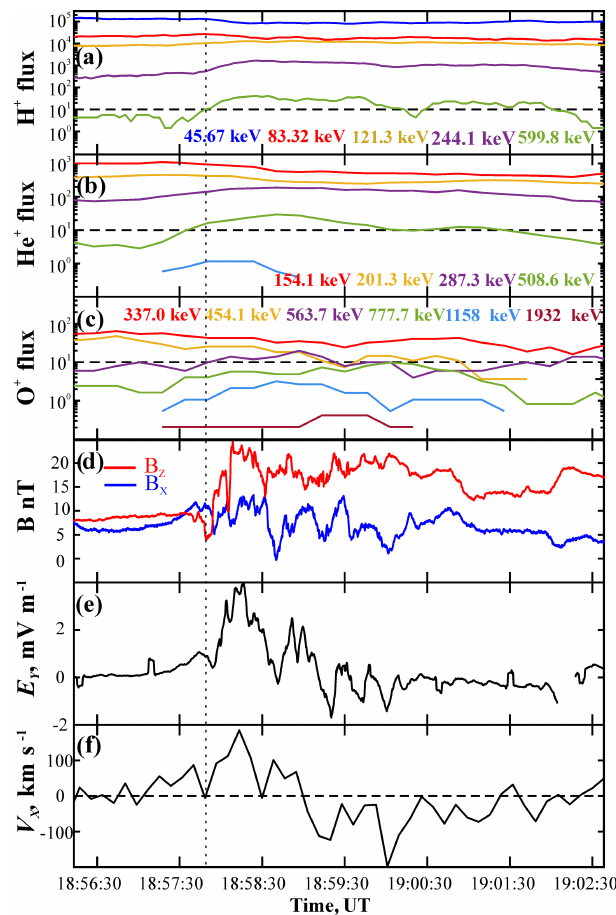
Figure 1. An overview of the dipolarization event observed on 3 October 2004 by Cluster-1. Panels (a) – (c) show the time profiles of fluxes of suprathermal H + , He + and O + ions respectively mea- sured by the RAPID instrument in the energy ranges indicated in the corresponding panel. Panel (d) shows time profiles of the B X and B Z components of the magnetic field. Panels (e) and (f) display the dawn–dusk electric field ( E Y ) and X component of ion bulk ve- locity ( V X ). The onset of dipolarization is indicated by a vertical dotted